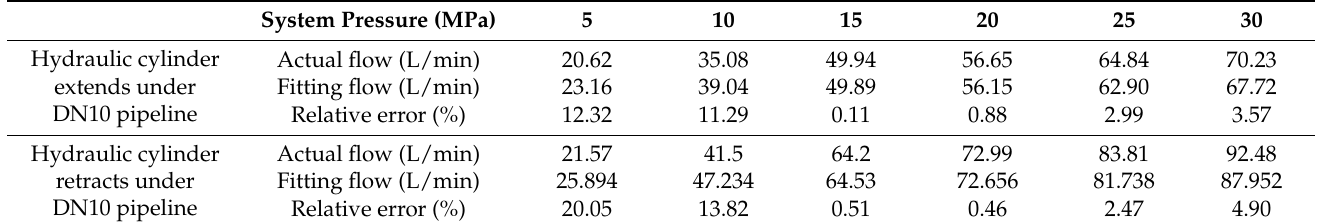
Table 5. Comparison between fitting flow and actual flow under DN10 pipeline.